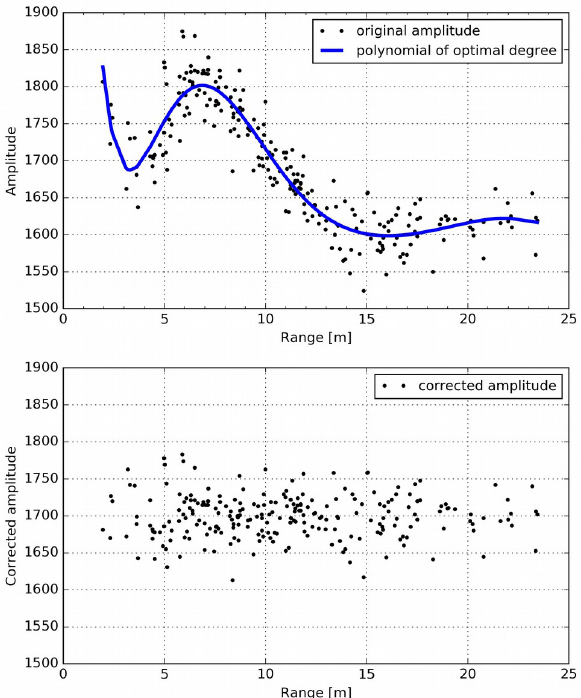
5. Top: Distribution of the original amplitude over range for all spheres on all plots. The reflections of each sphere have been averaged. The line visualizes the polynomial of optimal degree fitted to the distribution of amplitudes. Bottom: The distribution of amplitudes after polynomial correction.